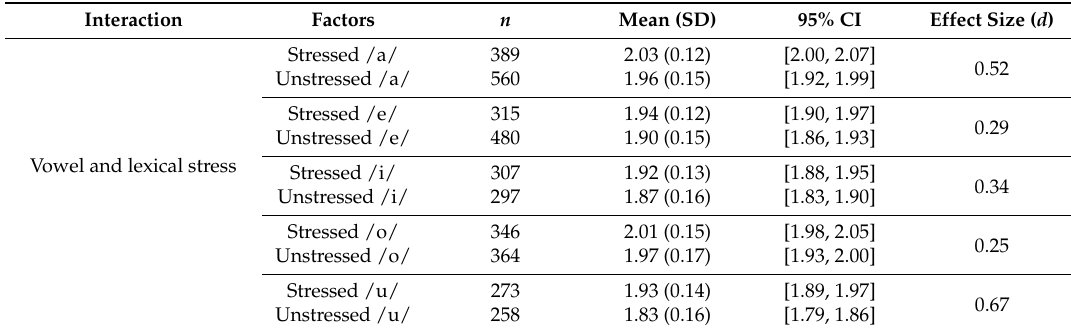
Table 6. Descriptive results for vowel duration